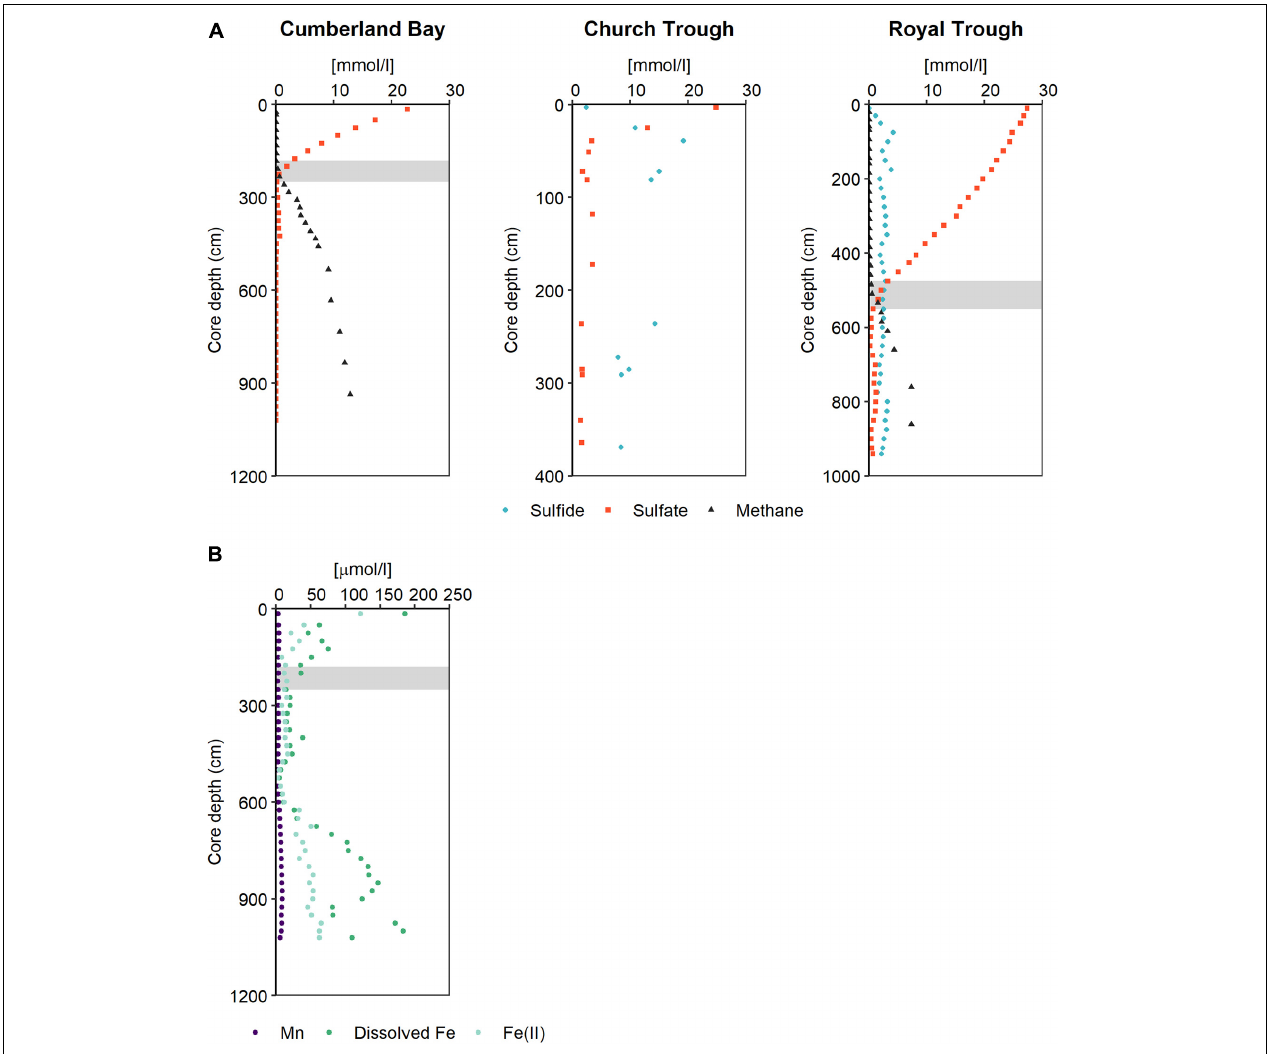
FIGURE 2 | Pore-water profiles reflecting the geochemical prerequisites for and products of AOM in South Georgia sediments. (A) Pore-water profiles of sulfate, sulfide, and methane in the sediments of Cumberland Bay, Church Trough, and Royal Trough. (B) Pore-water profiles of ferrous iron, total dissolved iron and manganese in sediments of Cumberland Bay. Gray bars indicate